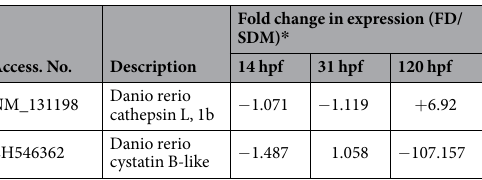
Table 1. The fold of expressional change for cathepsin L and CSTB-like obtained from microarray data. * Reported is the averaged transcripts ratio between FD and SDM larvae of all probes (ranging from 1 to 5 probes for each gene) specific to the different sequence segments of the same gene. FD, larvae with folate deficiency; SDM, larvae expressing a non-functional GGH by site-directed The transcripts of cathepsin L and a cystatin B-like (CSTB-like) protein were significantly increased and decreased, respectively, in FD larvae. To examine the impact of folate deficiency on the global gene expression profile during zebrafish embryogenesis, FD embryos at 14 hpf, 30 hpf and 120 hpf were subjected to microarray analysis. The expression profiles of both wild-type embryos and a transgenic line express- ing a non-functional γ -glutamylhydrolase were also examined to serve as comparison 17 . Of all the genes display- ing affected expression levels, cathepsin L and a CSTB-like protein (GenBank TM accession number EH546362) were among those with the most apparent changes at 120 hpf (Table 1). The alteration in the mRNA levels of cathepsin L and zCSTB-like in FD larvae was confirmed with RT-PCR (Fig. 3A). Additionally, the cathepsin L transcript expression levels were increased and exhibited a positive correlation with the FD severity of the larvae. Western blotting results showed that cathepsin L was abundant in wild-type embryos at 48 hpf but vanished after